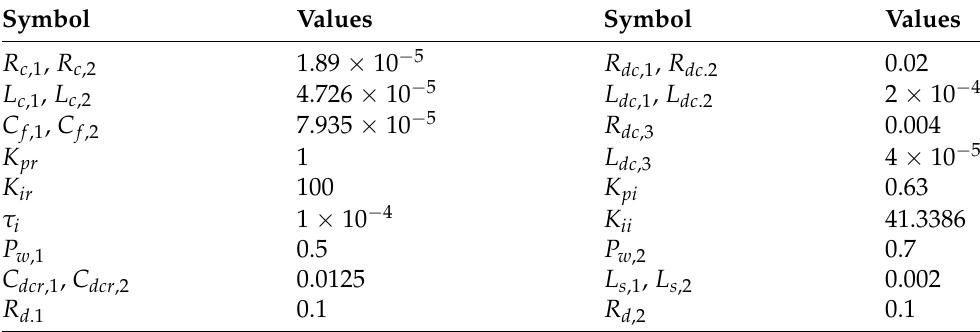
Figure 5. Pole placement of the proposed state-space (SS) model. Table 1. Parameters of the test